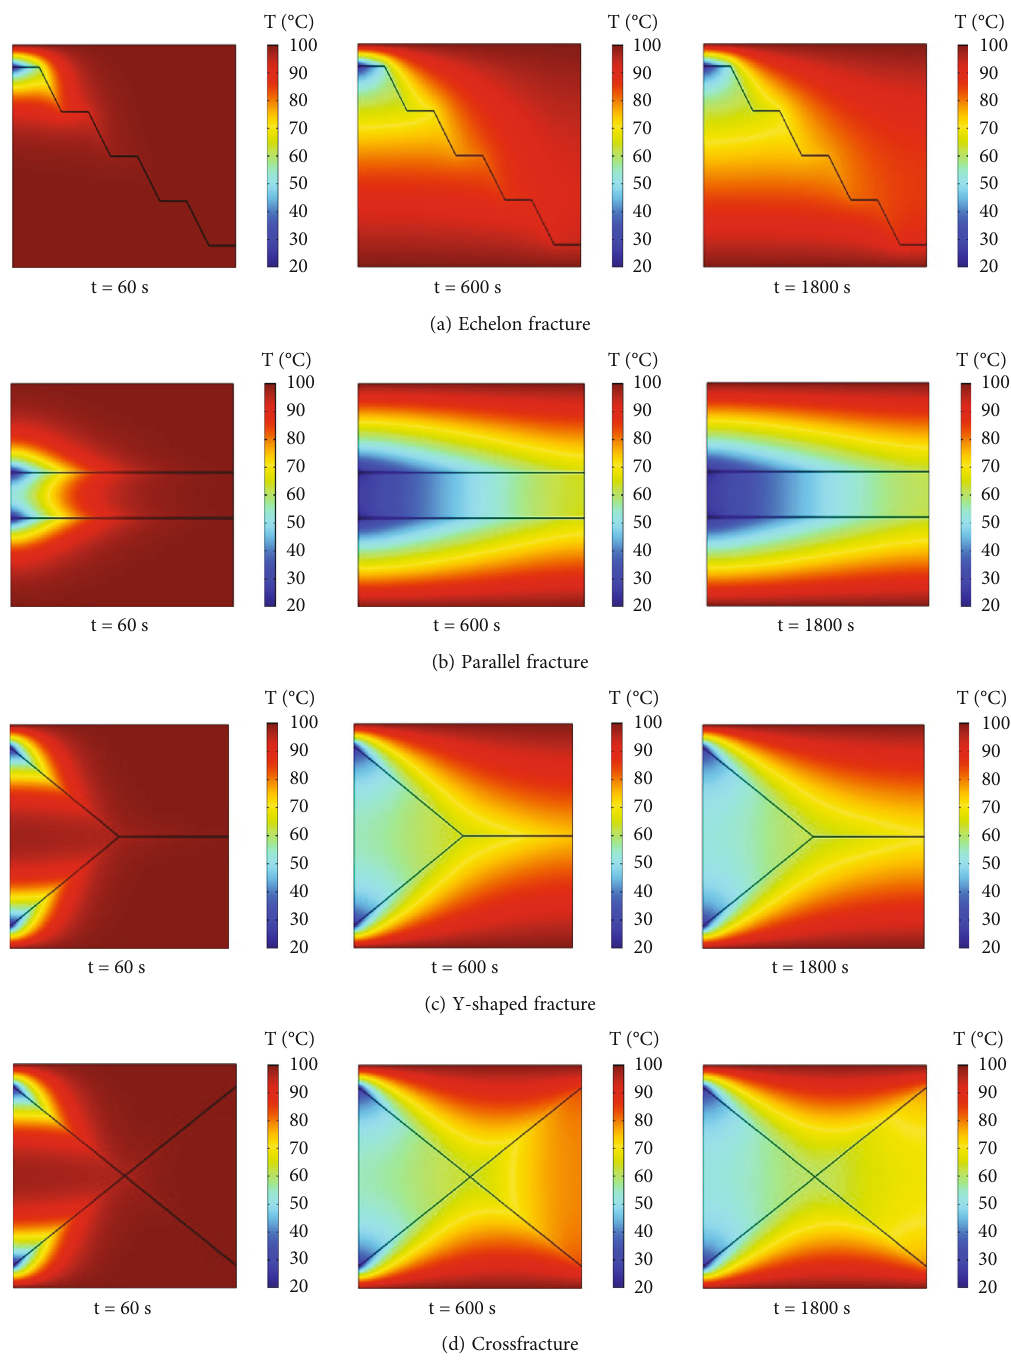
Figure 7: Temperature fi eld evolution of fractured granite with di ff erent